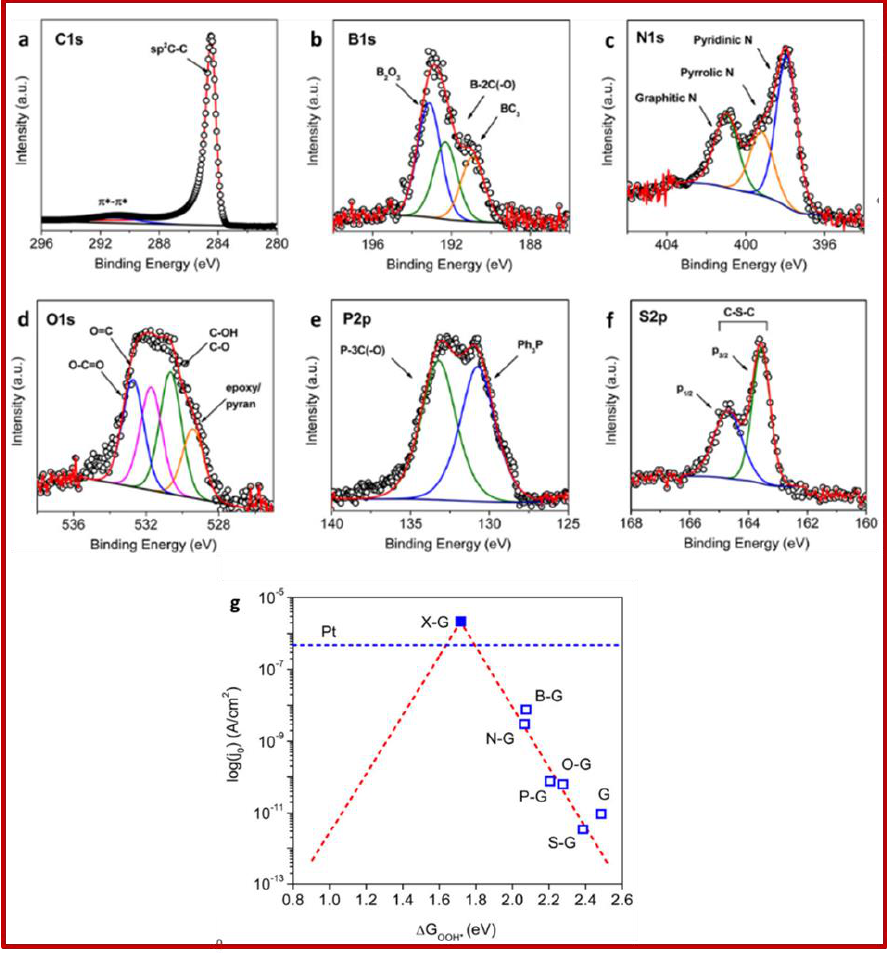
Figure 10. Left panels: High-resolution XPS spectra of different heteroatoms in doped graphene layers: ( a ) graphite. The main peak is due to sp 2 C–C bonds, the lower intensity peak is due to the π plasmon; ( b ) B-graphene with contributions of B 2 O 3 (blue), B–2C–O (green), BC 3 (yellow); ( c ) N- graphene with graphitic (green), pyrrolic (yellow) and pyridinic (blue) contributions; ( d ) O-graphene with O-C=O (blue), O=C (pink). C–OH and C–O (green) and epoxyl pyran (yellow) contributions; ( e ) P-graphene with P–3C(–O) (green) and Ph 3 P (blue) contributions; ( f ) S-graphene with the S doublet of the C–S–C group. Right panel ( g ): Volcano plot between j 0 theory and ∆ GOOH* with charge-transfer coefficient α = 0.5 (red dashed line). Blue hollow squares are j 0expt obtained from Tafel plots, and DFT derived ∆ G OOH* for each doped graphene catalyst. Taken with permission from Ref. [52]. Copyright by ACS.